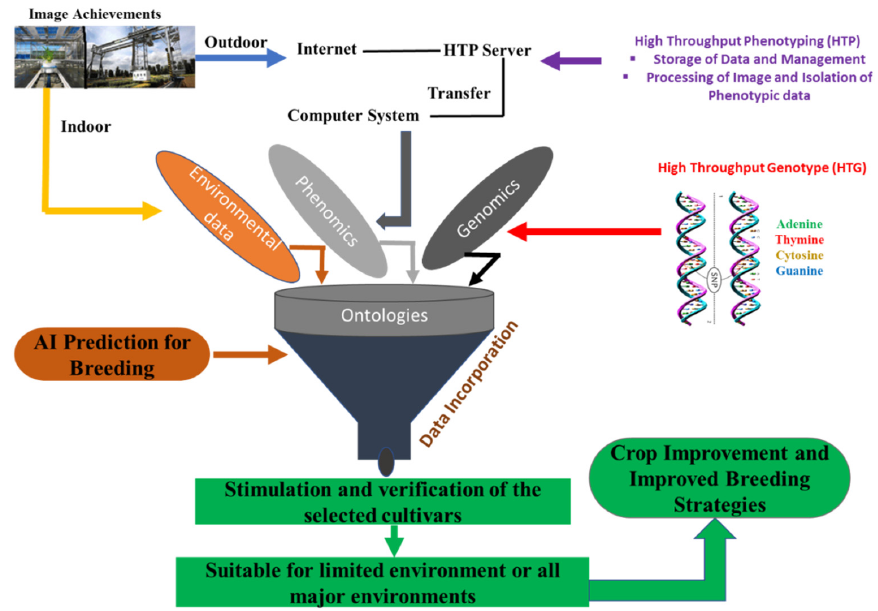
Figure 2. Integration and management of Genomics, Phenomics, and Enviromics data by artificial intelligence for crop-breeding improvement. The phenotypic data of crops are collected from both indoor and outdoor environments, the information of phenotypic, genotypic and environmental are combined together with AI technology. With mathematical modelling, logical deduction, and decision-making, the AI-assisted breeding system will simulate and verify the selected cultivars, whether it is suitable for cultivation in limited environments or all major environments.